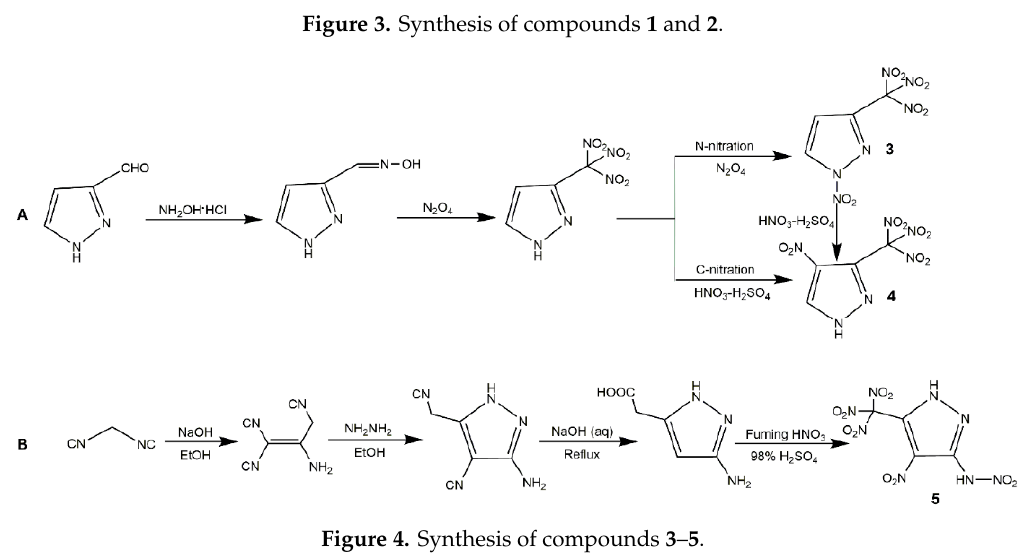
Figure 4. Synthesis of compounds 3 – 5.